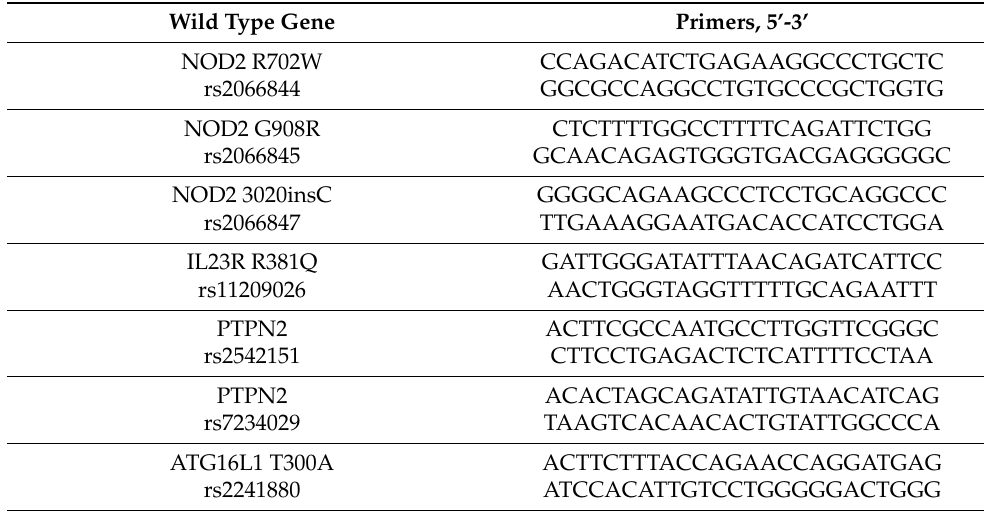
Table 1. Primers for polymerase chain